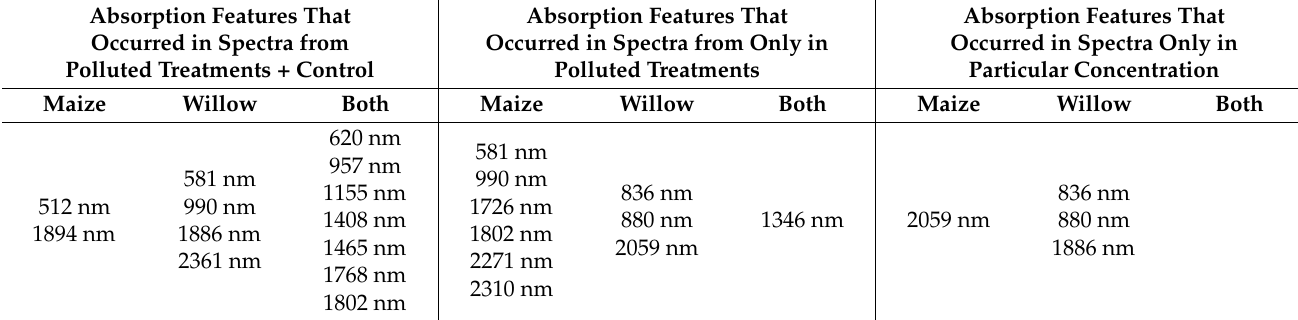
Table 2. Major absorption features appearing in the control and polluted treatments for both willow and maize plants. Absorption Features That Absorption Features That Absorption Features That Occurred in Spectra from Occurred in Spectra from Only in Occurred in Spectra Only in Polluted Treatments + Control Polluted Treatments Particular Concentration Maize Willow Both Maize Willow Both Maize Willow